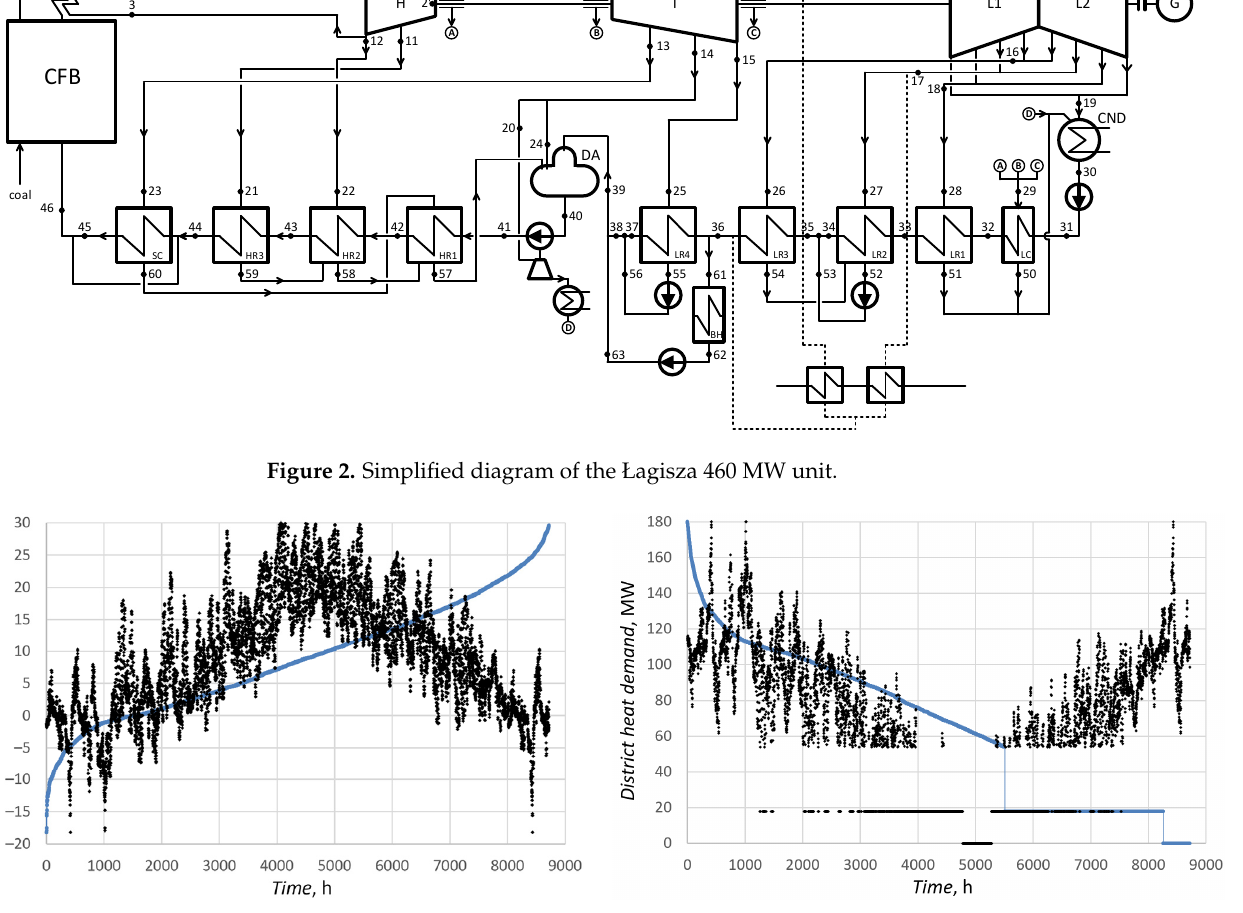
Figure 4. Integration diagram of 3 nuclear reactors with the steam turbine unit (Case REF_3NR).